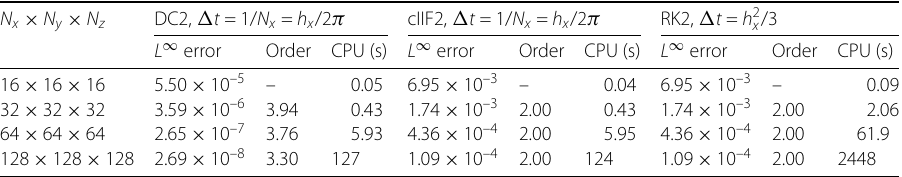
Table 3 Error, order of accuracy, and CPU time with DC2, cIIF2, and RK2 schemes for Example 2 N x × N y × N